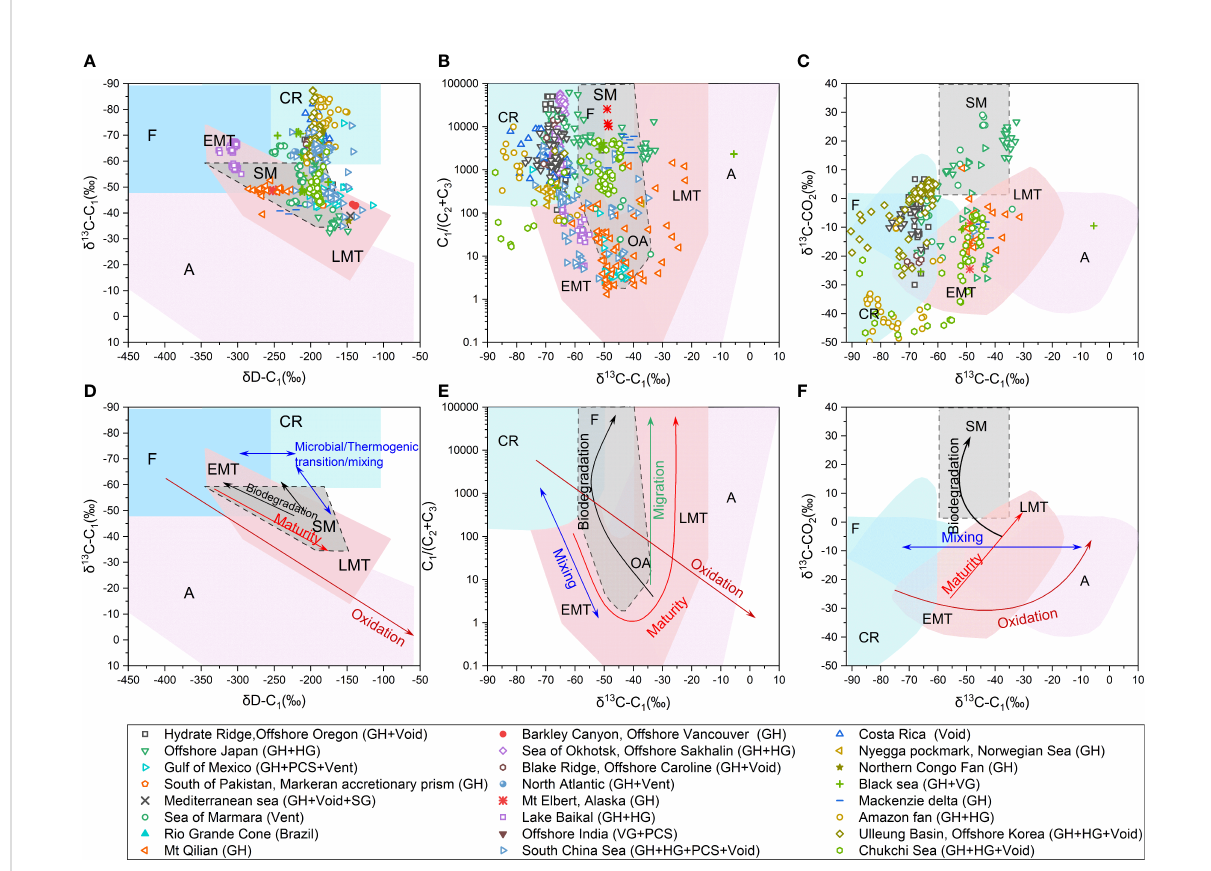
FIGURE 5 Genetic diagram of d 13 C-C 1 versus d D-C 1 (A) ; d 13 C-C 1 vs. C 1 /(C 2 +C 3 ) (B) ; d 13 C-C 1 vs. d 13 C-CO 2 (C) with dataset plotted in. Genetic diagram of d D-C d 13 C-C d 13 C-C d 13 C-CO d 13 C-C 1 versus 1 (D) ; 1 vs. C 1 /(C 2 +C 3 ) (E) ; 1 vs. 2 (F) with secondary alteration processes (migration, mixing, biodegradation, oxidation and maturity) plotted, modi fi ed from (Milkov and Etiope, 2018). EMT-early mature thermogenic; OA-oil